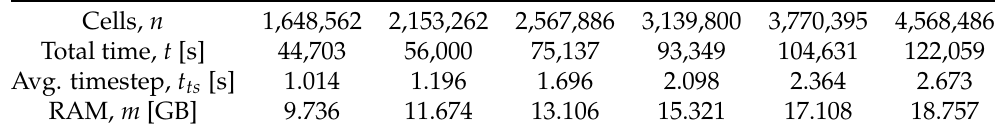
Table A7. AMR generated grids when using the k − ω TNT model. Refinement frequency is set to 1000 timesteps. Load balancing is disabled. AMR specifics are defined in the manuscript. Presented values are three-run averages. A total of 48 cores are used for all tests.